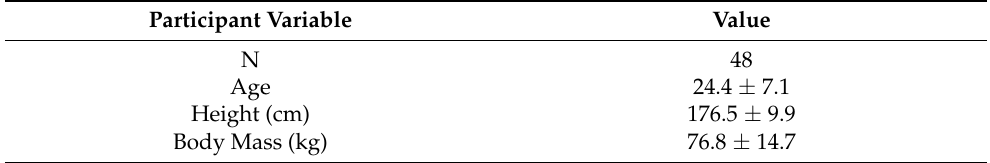
Table 1. Descriptive data of